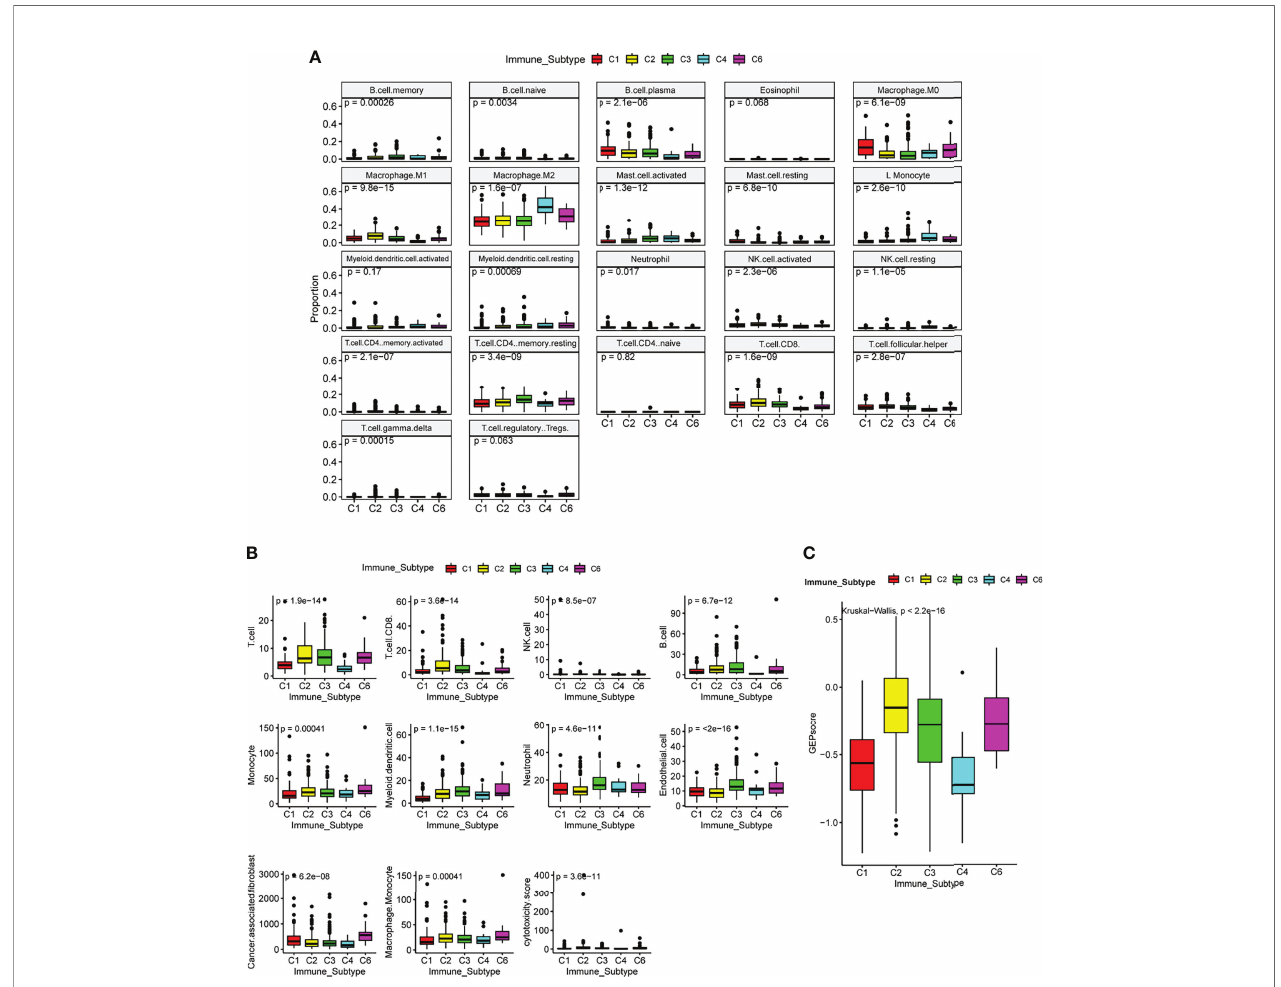
FIGURE 5 | Immune and stromal cell populations of the immune subtypes in TCGA LUAD cohort. Immune and stromal signatures were estimated by CIBERSORT (A) , MCP-counter (B) , and GEP score (C) in LUAD patients by immune subtypes. P-value was calculated by the Kruskal Wallis